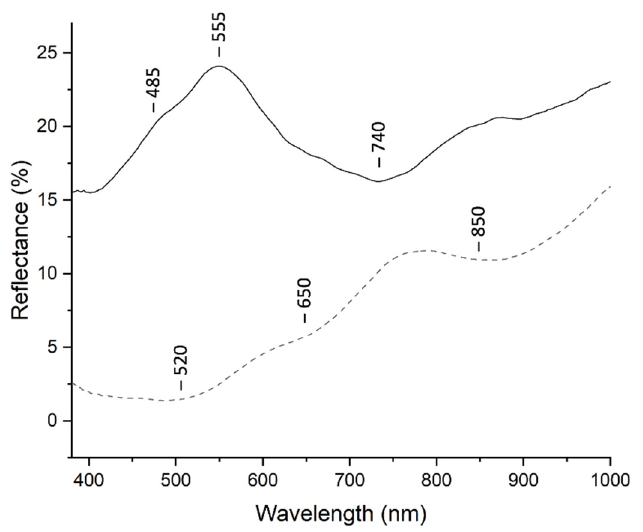
Figure 7. FORS spectra of green earth (solid line) in point 9 of 8r and brownish earth (dotted line) in point 12 of 8r.